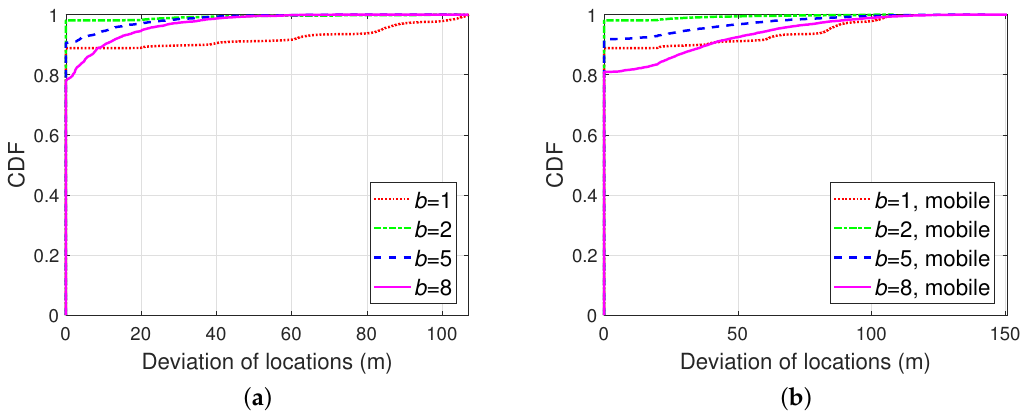
Figure 7. CDF of deviation of retrieved locations: ( a ) with different subdivisions; ( b ) with different subdivisions and